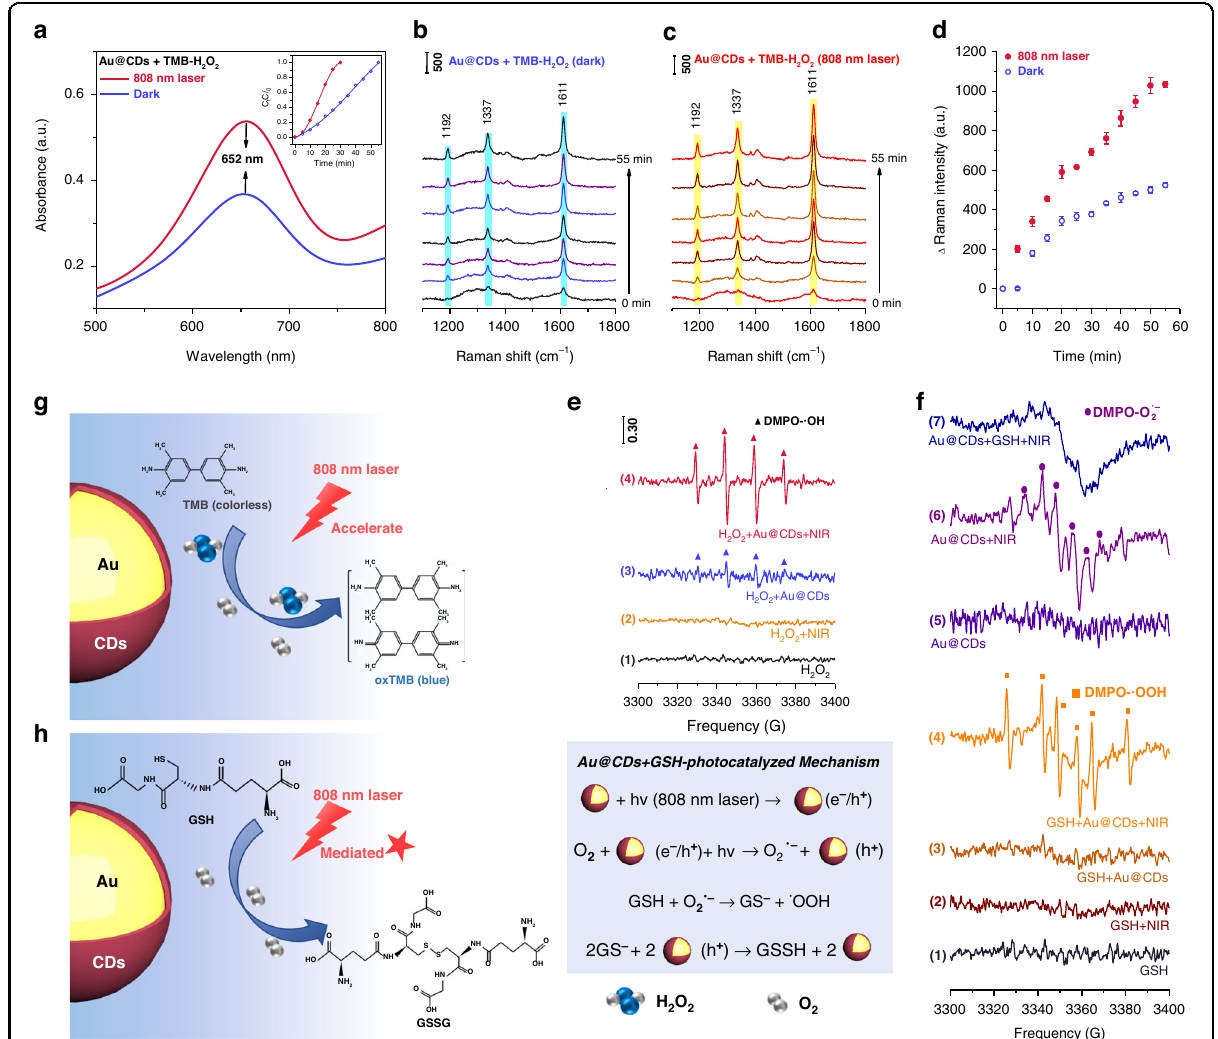
Fig. 4 Photoinduced enhanced enzyme-like catalytic properties of Au@CDs. a UV – vis spectra of Au@CDs + H 2 O 2 + TMB systems in darkness or under 808 nm laser irradiation (react for 30 min), b SERS monitoring of Au@CDs + H 2 O 2 + TMB systems in darkness and c under 808 nm laser irradiation. d SERS intensities of peaks at 1611 cm – 1 versus times. e EPR spectra of varied systems: (1) H 2 O 2 , (2) H 2 O 2 + NIR, (3) H 2 O 2 + Au@CDs, (4) H 2 O 2 + Au@CDs + NIR. DMPO was used as spin adduct and NIR light is from 808 nm laser. f EPR spectra of varied systems: (1) GSH, (2) GSH + NIR, (3) GSH + Au@CDs, (4) GSH + Au@CDs + NIR in aqueous solution and (5) Au@CDs, (6) Au@CDs + NIR, (7) GSH + Au@CDs + NIR in methanol solution. DMPO was used as spin adduct and NIR light is from 808 nm laser. g Possible mechanism for the photoinduced enhanced POD-mimicking activities and h the photo-mediated GSHOx-mimicking activities under 808 nm laser